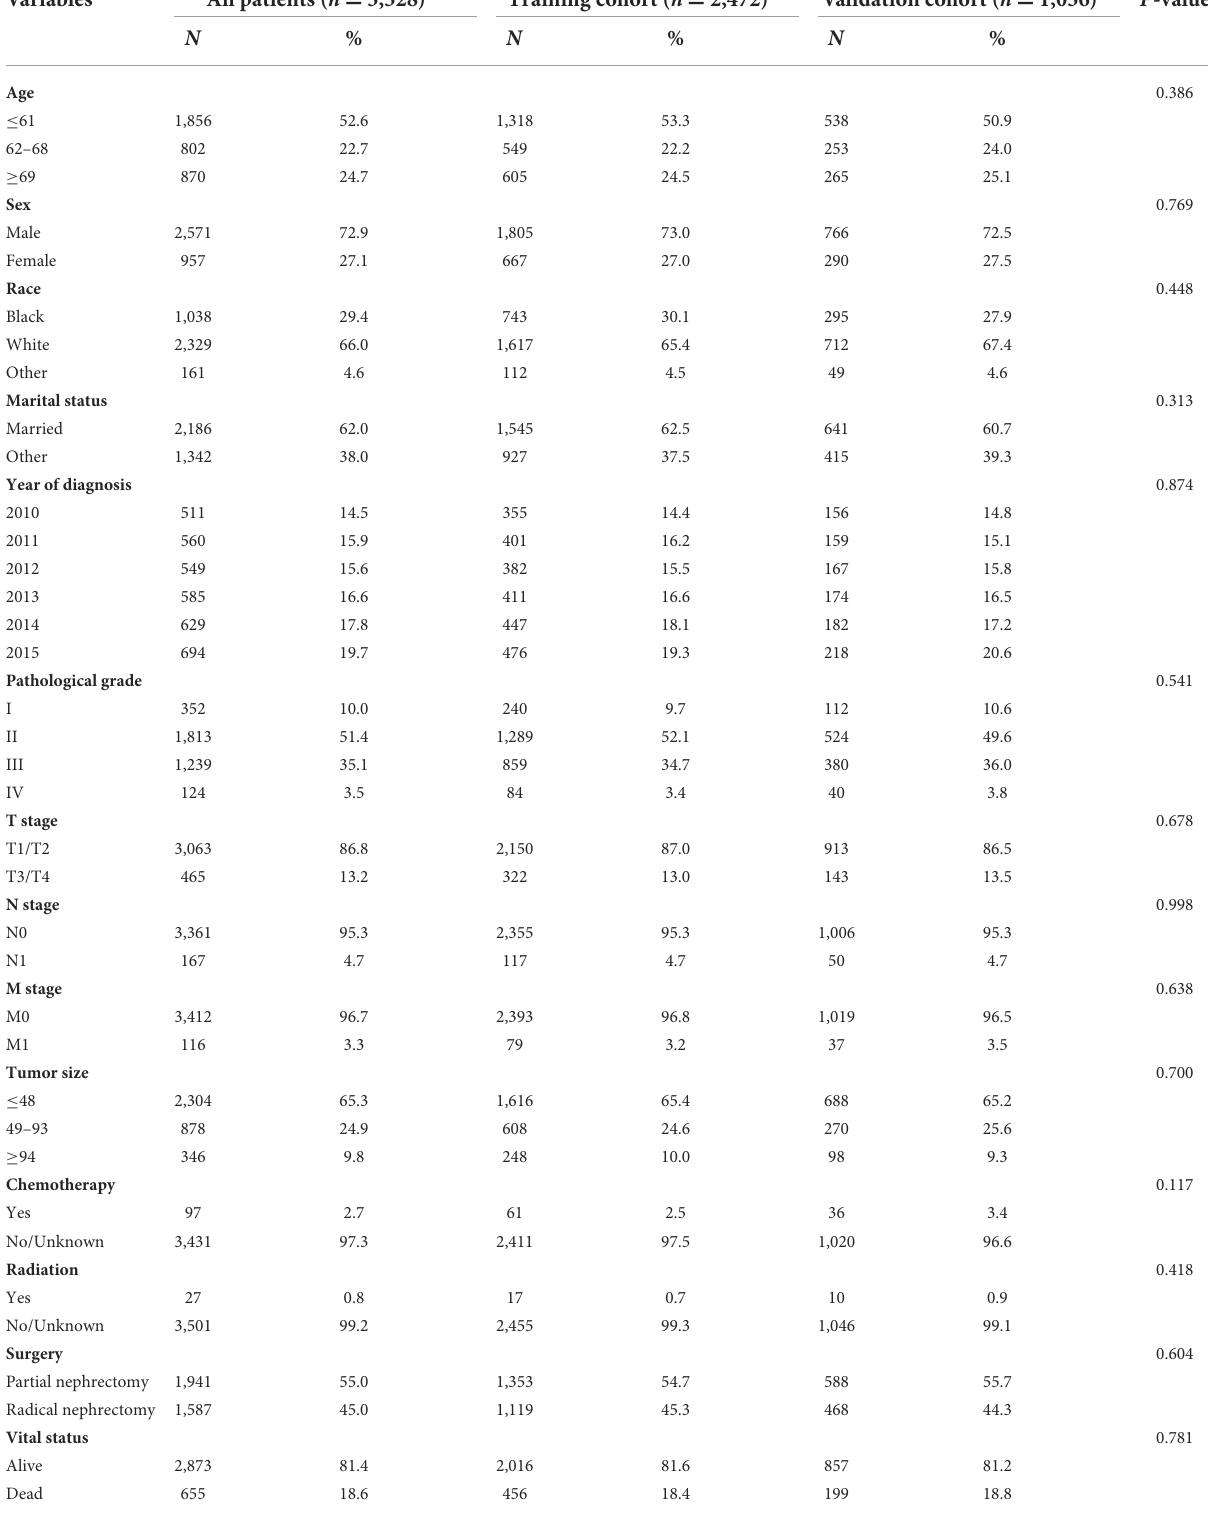
TABLE 1 Baseline characteristics of patients with papillary renal cell carcinoma after